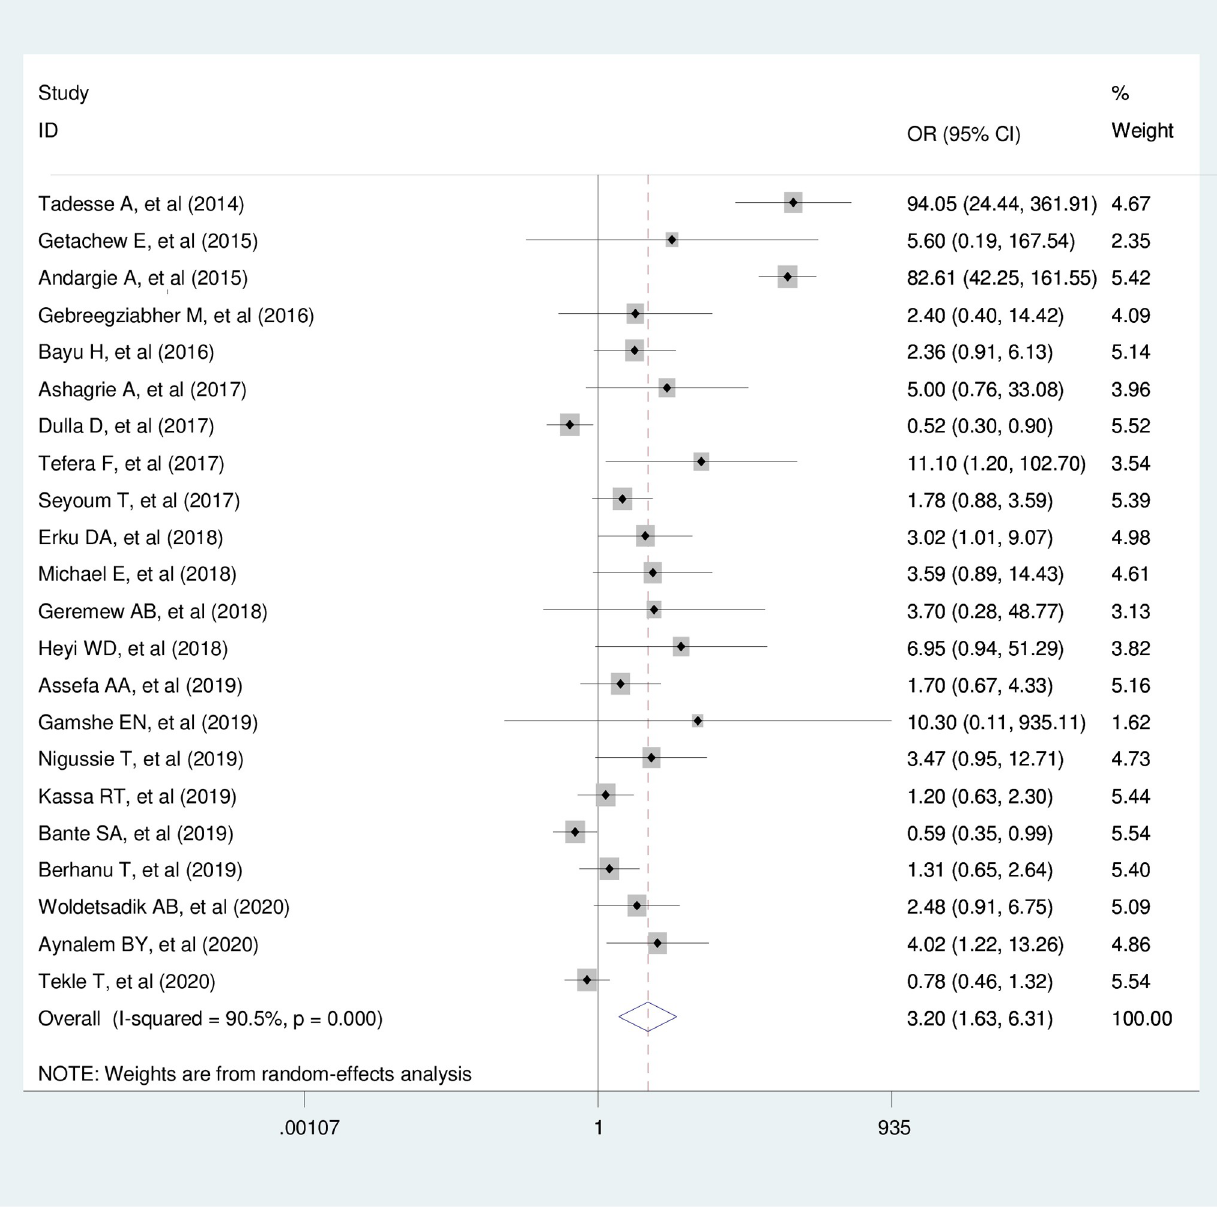
Fig 6. The pooled effect of knowledge on cervical cancer screening service utilization. Egger’s regression test also showed that there was no publication bias for the studies included to estimate the pooled effect of knowledge on cervical cancer screening service utilization among women (P = 0.062).